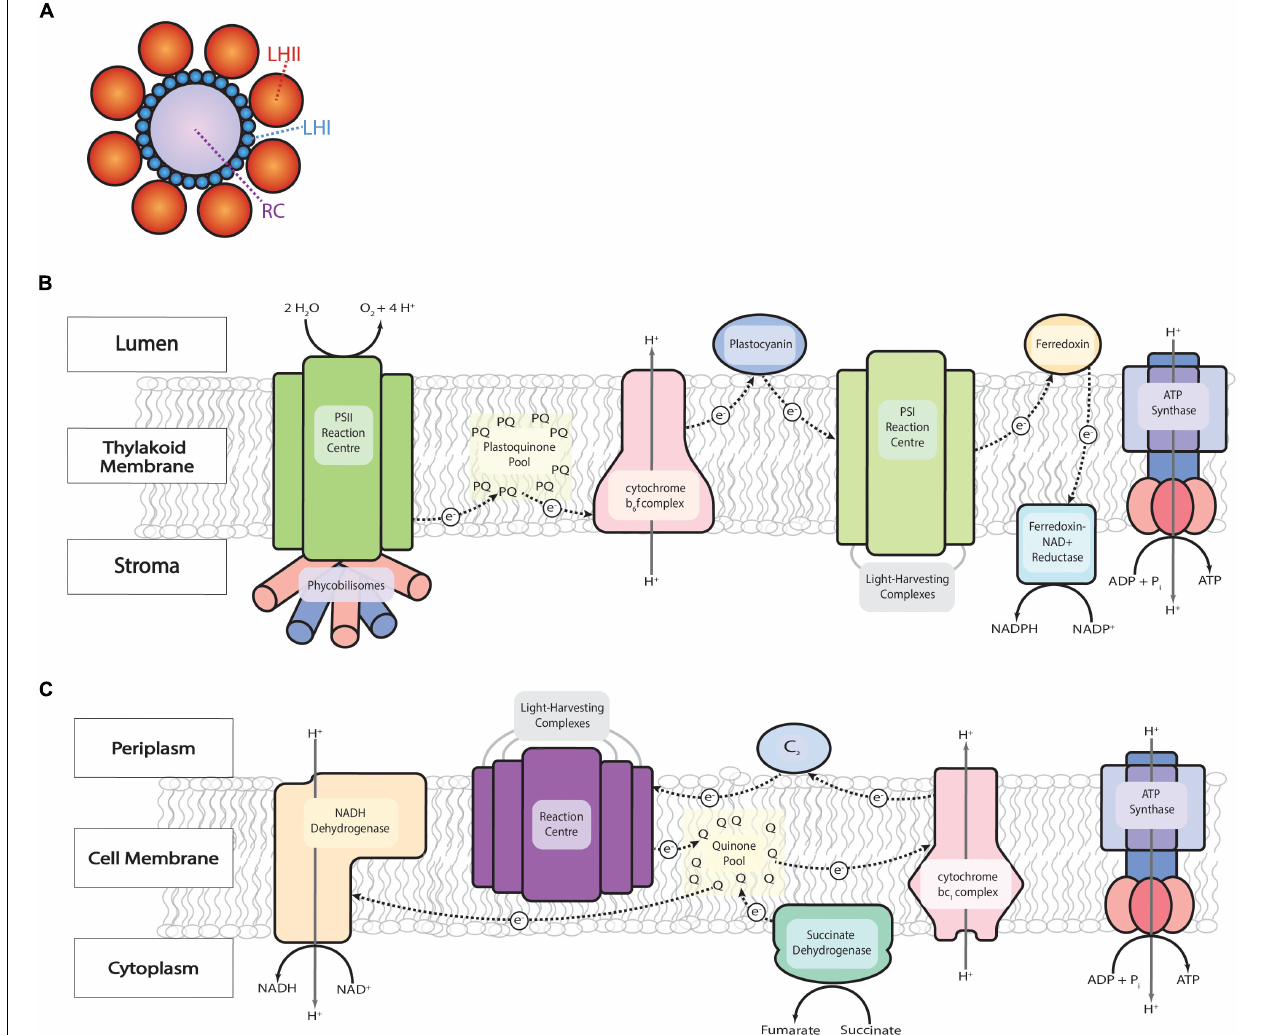
FIGURE 1 | The ETC of oxygenic and anoxygenic photosynthesis. (A) Arrangement of light harvesting complexes (LH) around the reaction center (RC) of photosynthetic bacteria with two types of light harvesting complexes. Based on an atomic force micrograph of Phaeospirillum molischianum (Fassioli et al., 2009). (B) In oxygenic photosynthesis, as in cyanobacteria, there is a two-stage process of electron excitation. Solar energy is absorbed by the light-harvesting antenna complexes that surround the reaction center of Photosystem II (PSII) and transferred by resonance energy transfer to its reaction center where water is split, oxygen is released, hydrogen protons create a proton gradient across the membrane, and electrons begin to travel down the ETC first to the plastoquinone (PQ) pool then to the cytochrome b 6 f complex. The cytochrome b 6 f complex pumps more protons across the membrane and transfers electrons to Photosystem I (PSI) via plastocyanine and then transferred to ferredoxin- NADP + reductase via ferredoxin to reduce NADP + to NADPH. (C) Anoxygenic photosynthesis, as in PNSB, is simpler than that of oxygenic photosynthesis as there is only one reaction center for the excitation of electrons (e - ) and the flow of these electrons is cyclic. The light-harvesting complexes accept photons and transfer energy to the reaction center where electron excitation occurs and begins to travel along the ETC to quinone (Q), cytochrome bc 1 , and cytochrome c 2 (c 2 ) generating a proton motive force whereby ATP can be synthesized via ATP synthase. PNSB benefits from a large buildup of an electrochemical energy that creates a reverse electron flow from the quinone pool to NADH dehydrogenase to produce NADH from NAD +